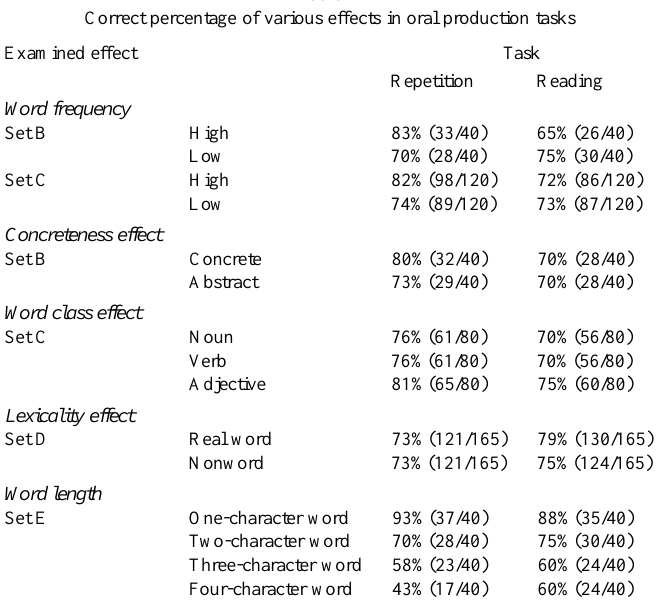
Table 2 Correct percentage of various effects in oral production